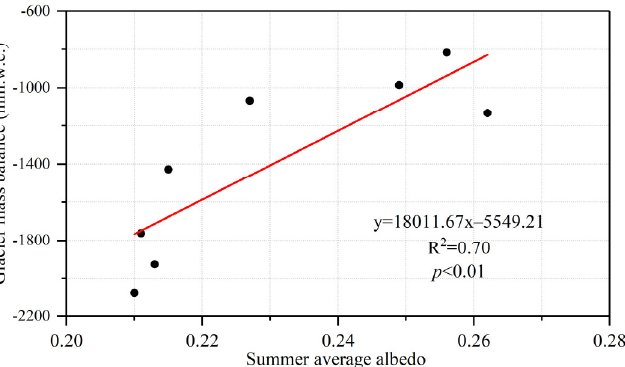
Figure 8. Relationships between summer average albedo and annual glacier mass balance for the Muz Taw Glacier.